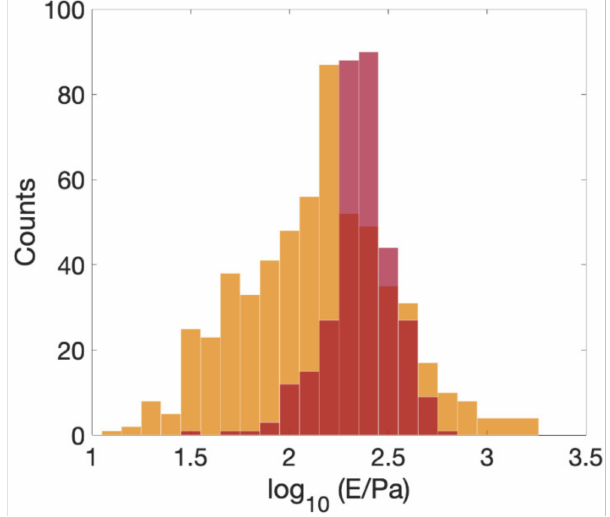
Figure 7. Histograms of the YM from the perinuclear and peripheral region of an RT112 cell (orange), and from the nuclear region (red).